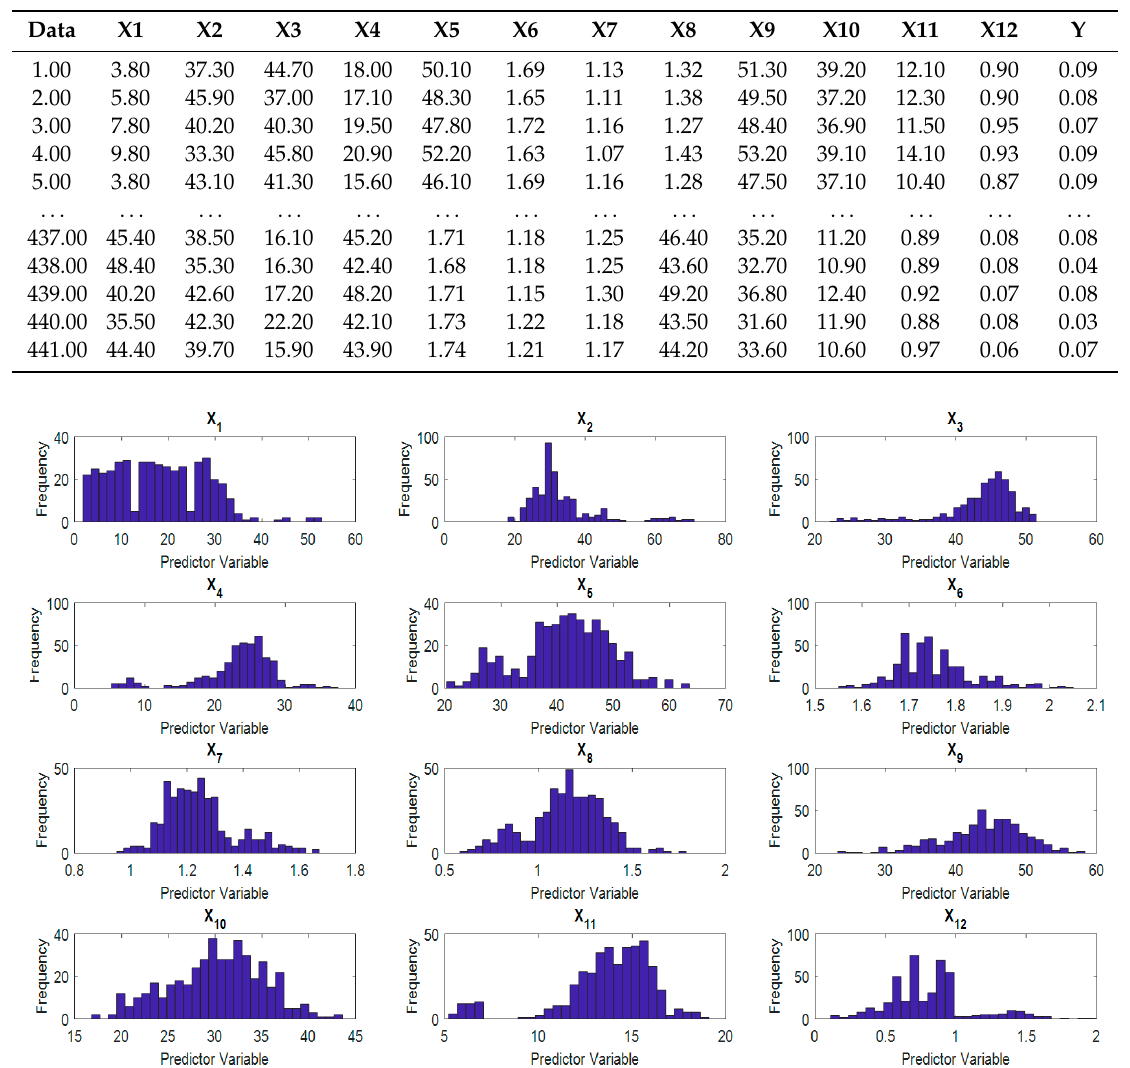
Table 2. Demonstration of the collected dataset.